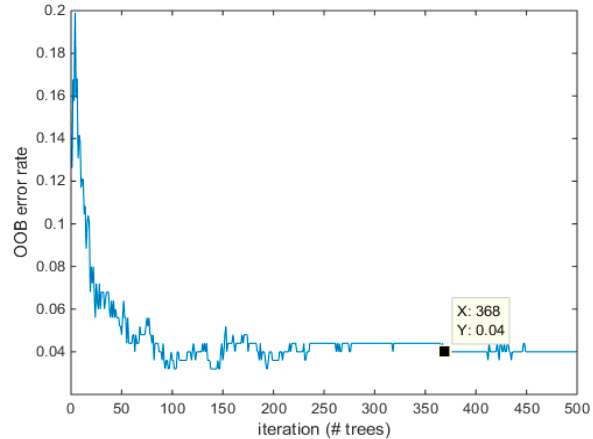
Figure 6. Value of OOB error varies with the number of decision trees.